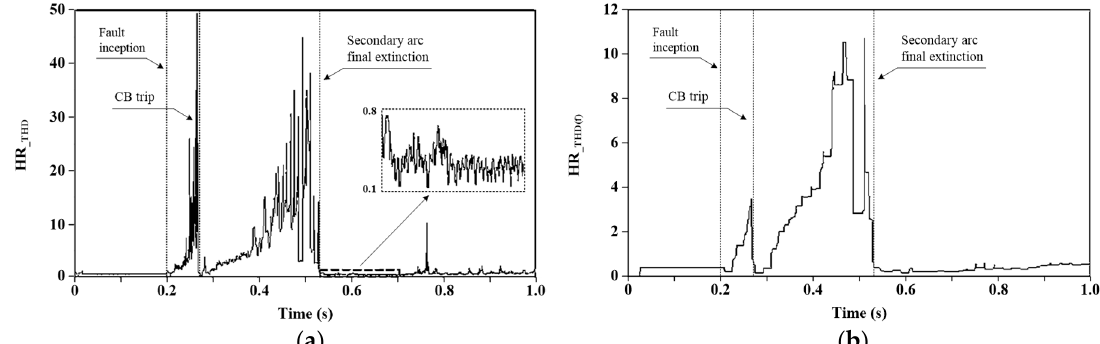
Figure 12. Harmonic Ratio (HR) calculation results for Figure 4a: ( a ) HR_ THD ; ( b ) HR_ THD(f).